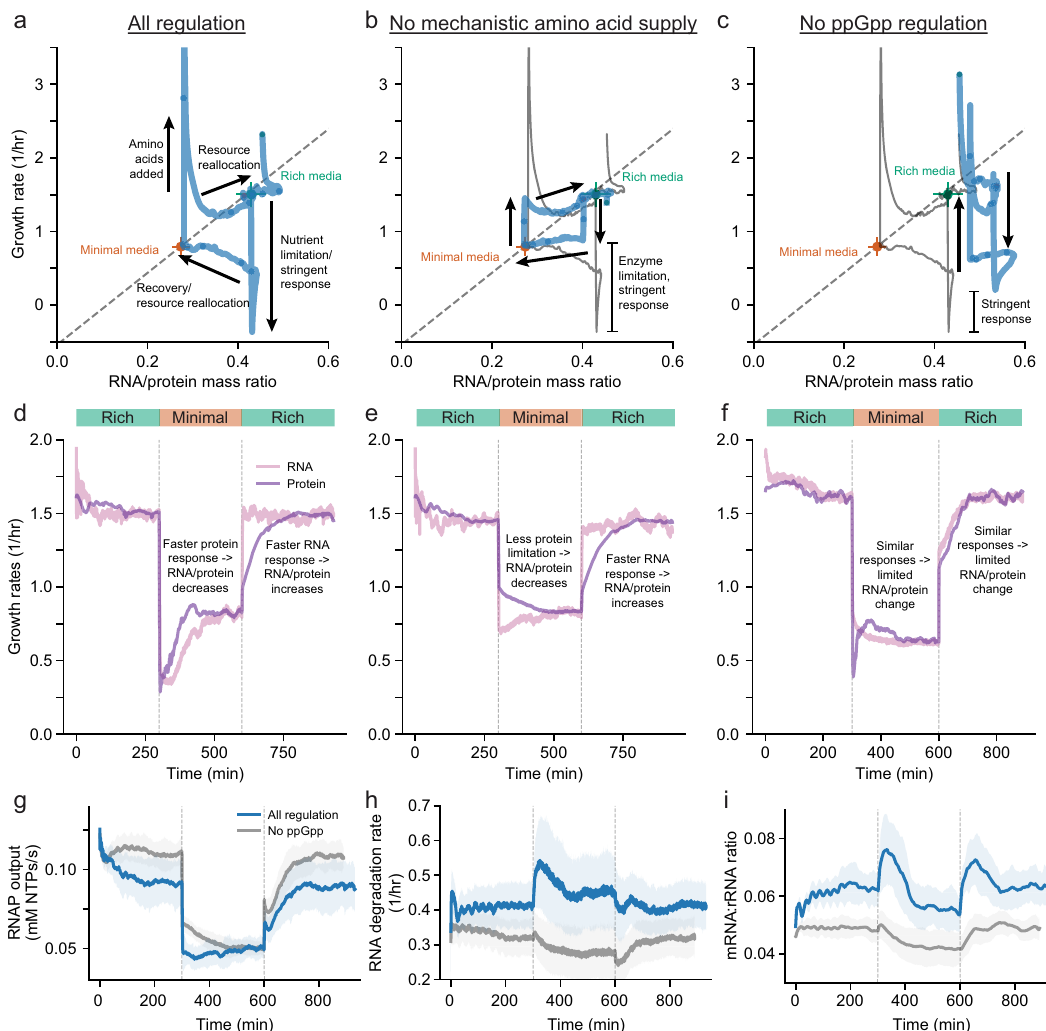
Fig. 5 Environmental shifts temporarily deviate from the expected growth rate vs RNA/protein ratio trend as the cell reallocates biomass to optimize growth. Growth rate and RNA/protein mass ratio plotted over time starting in rich media, removing amino acids from the media and adding amino acids back once the cell has adjusted to the new media with all regulation ( a ), no mechanistic amino acid supply ( b ) and no ppGpp regulation ( c ). The blue trace is an average of 32 cell lineages with circles indicating each hour of simulation. The stringent response shows a sharply suppressed growth rate immediately after an environmental downshift with all regulation. Without modeling kinetic amino acid supply, translation is not as limited so the full stringent response will not be activated. Without ppGpp regulation, the cellular composition has limited reorganization because there is not a differential response between the RNA and protein growth rates and the effect of the stringent response can be seen in the difference in growth rate response when compared to having ppGpp regulation included. Growth rate of RNA (light purple) and protein (dark purple) fractions of the cell over time are shown for all regulation ( d ), no mechanistic amino acid supply ( e ) and no ppGpp regulation ( f ). A higher protein growth rate will result in a decreasing RNA/protein ratio, while a higher RNA growth rate will result in an increasing RNA/protein ratio. RNA polymerase output ( g ), RNA degradation rate ( h ), and mRNA to rRNA mass ratio ( i ) for simulations with all regulation included (blue) compared to simulations with no ppGpp regulation (gray). Data comes from 28 generations and 32 initial